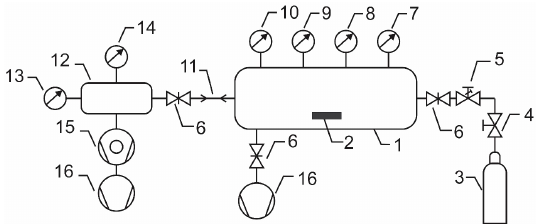
Figure 3. Schematic of the experimental setup: 1—plasma reactor, 2—sample, 3—oxygen flask, 4—high pressure valve, 5—leak valve, 6—gate valves, 7—double electrical probe, 8—optical spectrometer, 9—catalytic probe, 10—absolute vacuum gauge, 11—capillary, 12—high vacuum chamber, 13—high